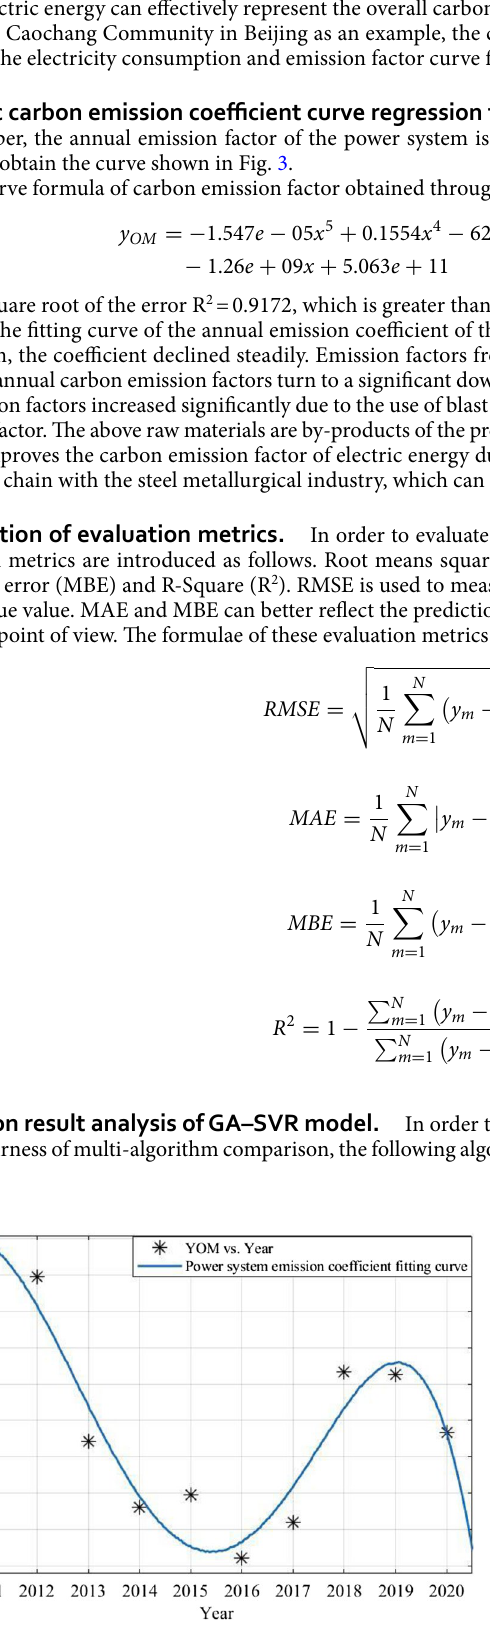
Figure 3. Power system emission coefficient fitting